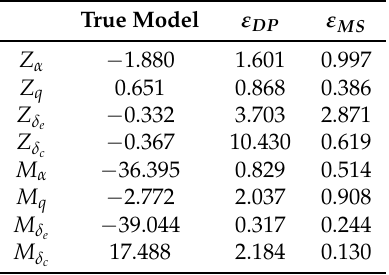
Table 1. The relative error (19) when using the double pulse (DP) and the crest factor optimized multisine (MS) input signals. The true model (17) is given as a reference.